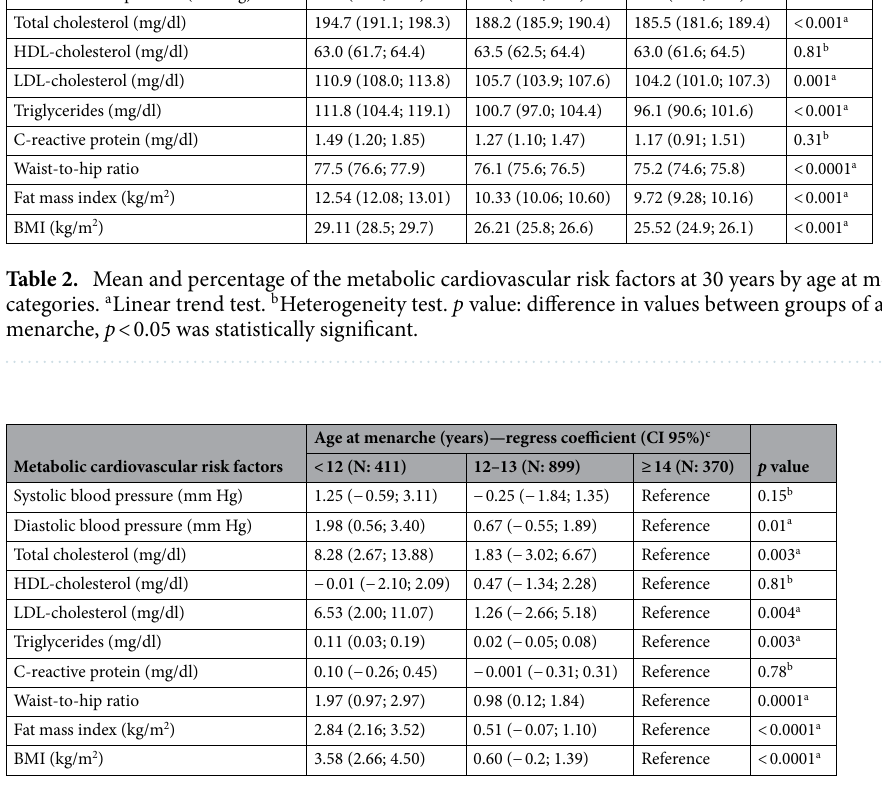
at menarche (< 12 x ≥ 14), except for systolic blood pressure, HDL-cholesterol and C-reactive protein, because the confidence interval includes the null value. The Supplementary Table 1 presented analysis for the association of age at menarche with additional metabolic cardiovascular risk factors. Pulse wave velocity, waist circumference, fat free mass index, abdominal visceral fat layer thickness and overweight even after controlling for confounding remained association with early age at menarche. Table 4 shows the results of the mediation analysis for each one of the body composition measures (BMI, fat mass index, waist-to-hip ratio) and the proportion mediated effect. Fat mass index captured most of the associa- tion of age at menarche with diastolic blood pressure (65.8%), carotid intima-media thickness (74.4%), pulse wave velocity (44.0%), LDL-cholesterol (98.9%), triglycerides (60.0%) and glycated hemoglobin (93.9%). The effect on systolic blood pressure, C-reactive protein and blood glucose was not mediated by fat mass index. BMI captured from 23.3 to 76.8% of the effect of early menarche with diastolic blood pressure, pulse wave velocity, total cholesterol, LDL-cholesterol and plasma glucose. These results are presented in last column of the Table 4. However, only diastolic blood pressure [fat mass index—NIE: 1.07 (0.24; 1.90)] and LDL-cholesterol [BMI—NIE: 3.50 (1.03; 5.97); waist-to-hip ratio—NIE: 2.66 (0.35; 4.97)] showed the evidence of mediation by body composi- tion, because the confidence intervals did not include the null value. Thus, fat mass index captured 65.8% of the association of age at menarche with diastolic blood pressure and, BMI and waist-to-hip ratio captured 76.8% and 47.8%, respectively, of the association of age at menarche with LDL-cholesterol.